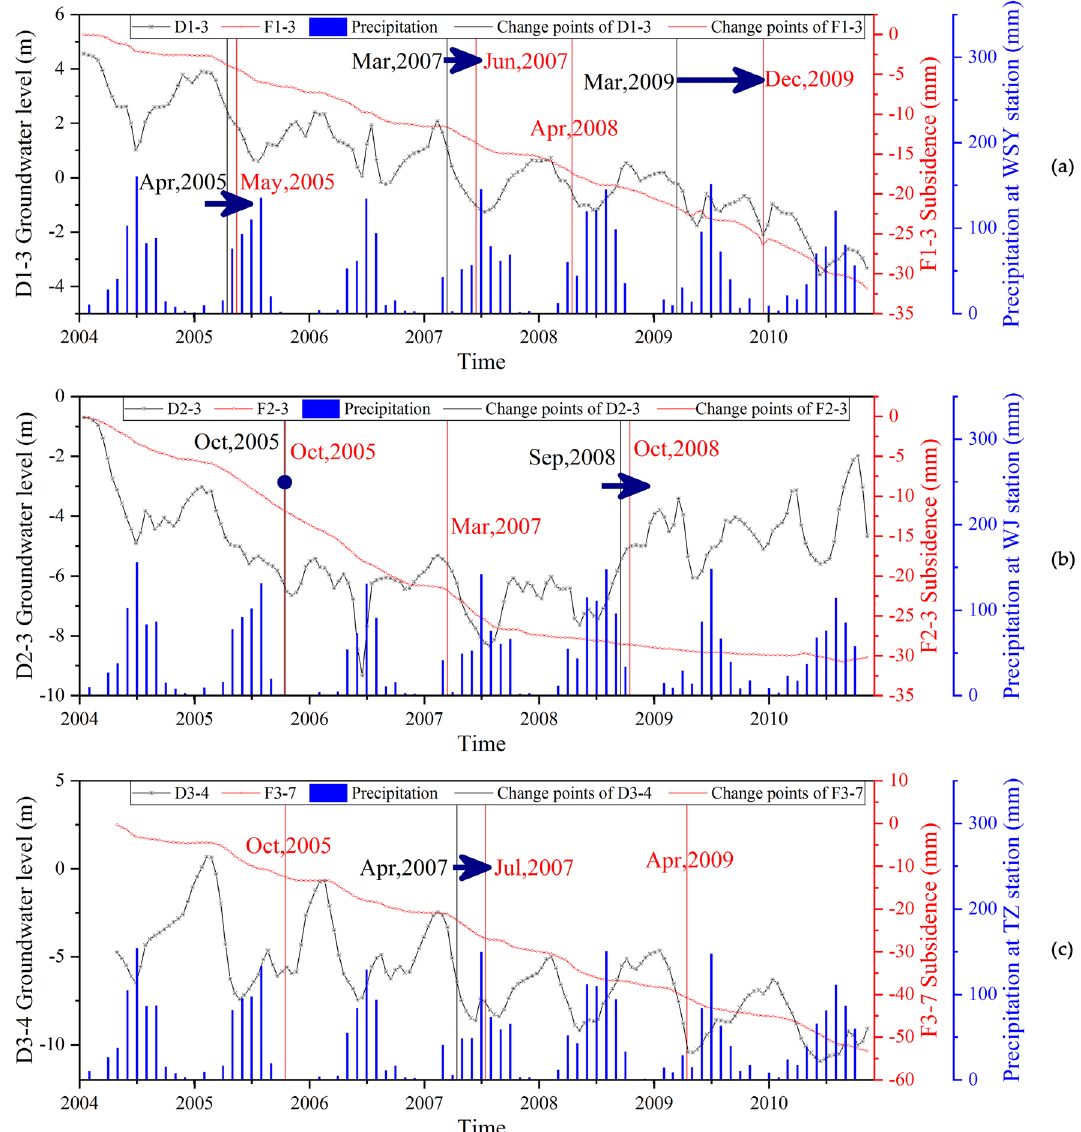
Figure 10. The relationship between the change points of the groundwater level and subsidence. The vertical black solid lines indicate the location of the change points of the groundwater level. The vertical red solid lines show the location of the change points of land subsidence. ( a ) Change points of D1-3 and F1-3 at WSY station. ( b ) Change points of D2-3 and F2-3 at WJ station. ( c ) Change points of D3-4 and F3-7 at TZ